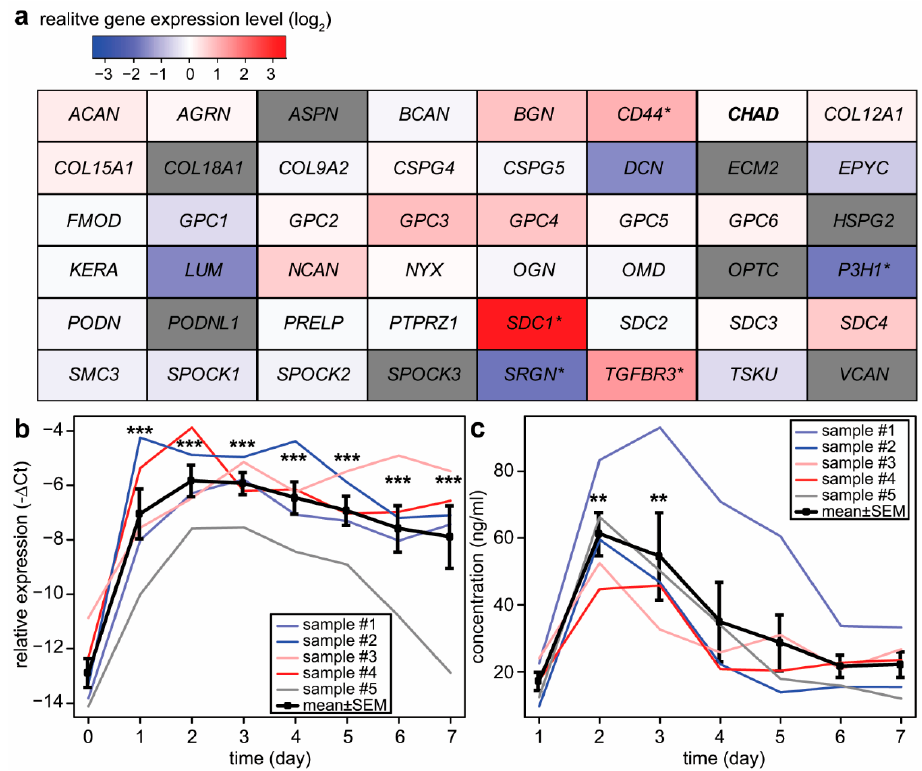
Figure 2. Changes in proteoglycan gene expression during villous trophoblast differentiation. ( a ) Microarray data were obtained from primary villous trophoblast cells isolated from third-trimester normal placentas (n = 3) during a seven-day differentiation period. The largest differences in gene expression compared to day 0 were visualized on a heatmap. Color code depicts log 2 gene expression ratios. Grey color: no data were available. The original study was published by Szilagyi et al. [52]. ( b ) SDC1 expression was monitored during villous trophoblast differentiation. qRT-PCR data were obtained from an extended set of primary villous trophoblast cells isolated from third- trimester normal placentas (n = 5) during a seven-day differentiation period. Relative expression of SDC1 , normalized to RPLP0 , was visualized on the diagraph. ( c ) Changes in syndecan-1 protein concentration in cell culture supernatants (n = 5) were examined throughout spontaneous syncytial differentiation of primary villous trophoblast cells. One-Way ANOVA with Dunnett’s post-hoc test was used for the analysis of qRT-PCR and ELISA results (* p < 0.05, ** p < 0.01, *** p < 0.001). Ribosomal Protein Lateral Stalk Subunit P0— RPLP0 ; syndecan-1— SDC1 . Cuffdiff analysis of RNA-seq data of Azar et al. found that DCN , lumican ( LUM ), and P3H1 were downregulated in the syncytiotrophoblast, while edgeR analysis of the same dataset revealed the downregulation of collagen type XII alpha 1 chain ( COL12A1 ), P3H1 , syndecan-4 ( SDC4 ), and structural maintenance of chromosomes 3 ( SMC3 ) as well as the upregulation of GPC3 [54]. In addition, single-cell RNA-seq data derived from the Human Protein Atlas also supports that the syncytiotrophoblast (isolated from first-trimester placentas) has the highest SDC1 expression compared to other trophoblast types in the placenta (Figure 3a) [55,56]. At term, expression of SDC1 remains the highest in the syncytiotrophoblast, as evidenced by a recent single-cell RNA-seq study searching for single-cell transcriptional signatures of the human placenta in term and preterm parturition (Figure 3b) [57].